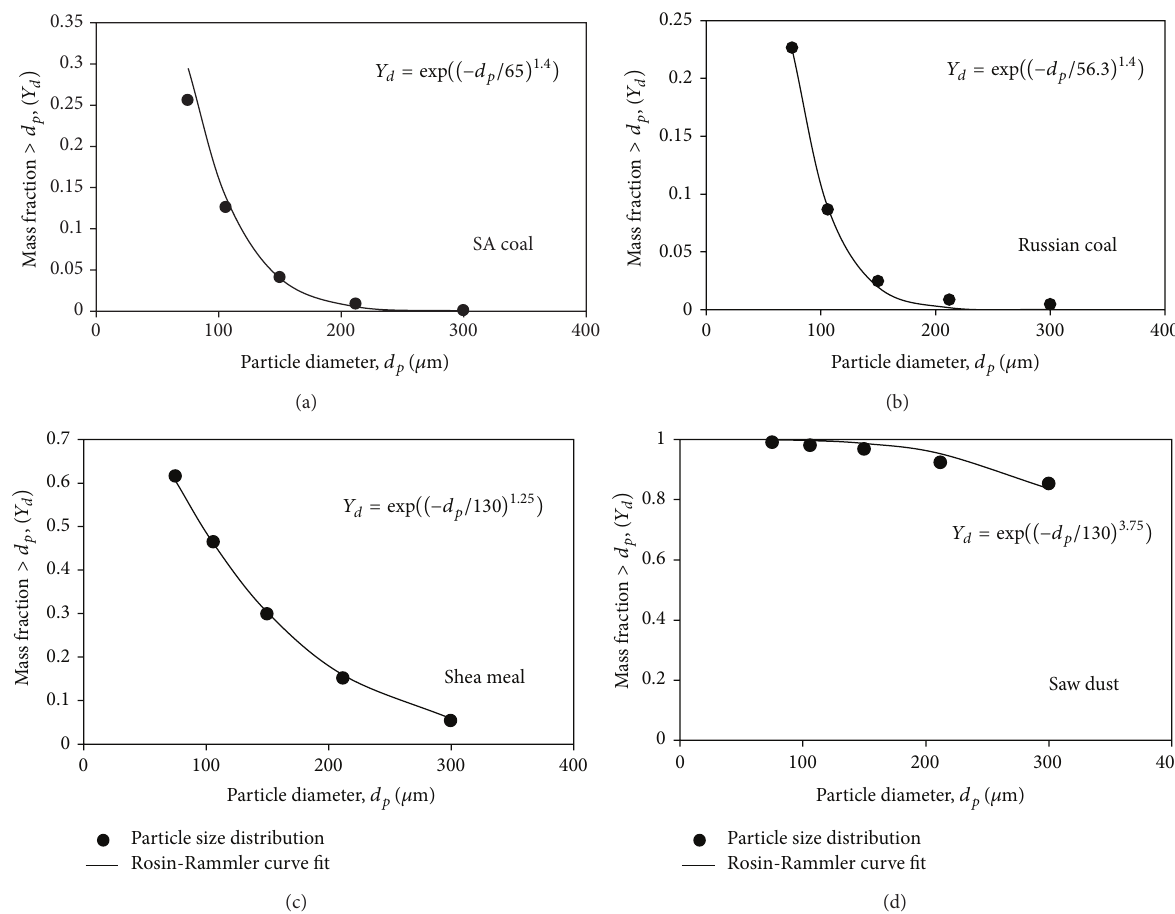
Figure 1: Fuel particle size distributions and Rosin-Rammler curve fits (a) SA coal; (b) Russian coal; (c) Shea meal; (d) saw dust.